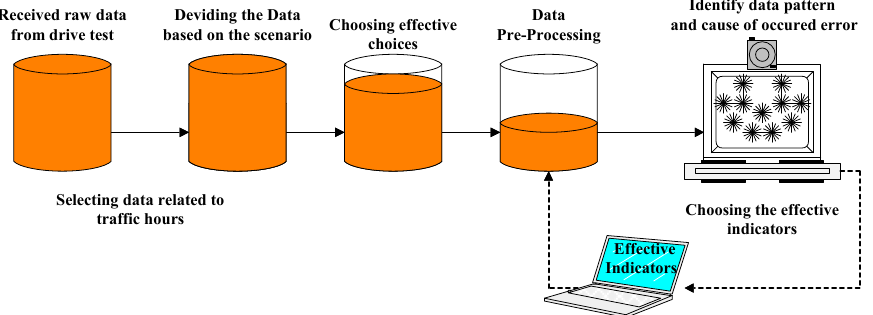
Figure 13. Architecture of working with drive test